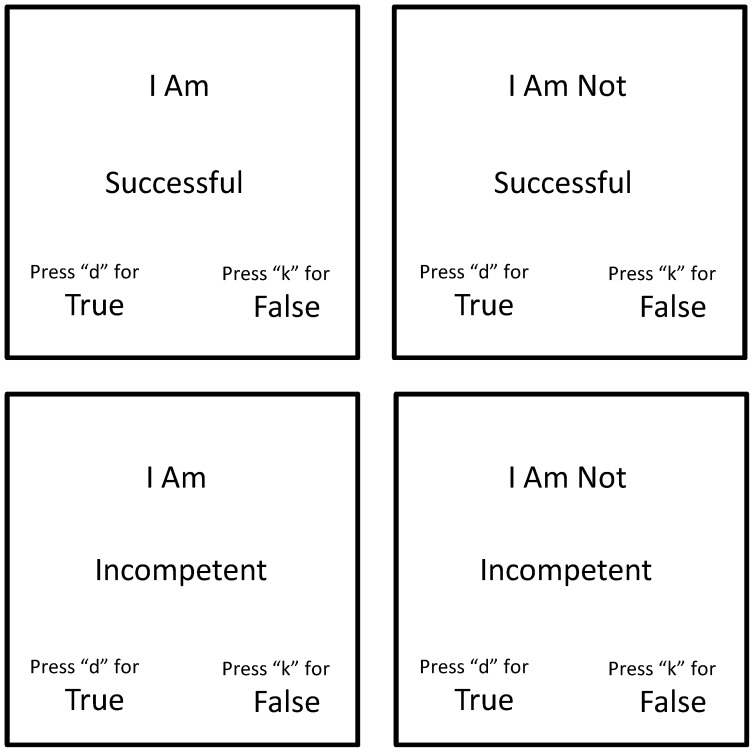
Examples of the four trial-types used in the actual self-esteem IRAP.On each trial, a label stimulus (e.g., ‘I am’ or ‘I am not’), a target stimulus (e.g., ‘Successful’ or ‘Incompetent’) and two relational response options (True and False) were shown on the screen. Note: the ideal and actual self IRAPs were identical in all regards except for their respective label stimuli (‘I want to be’ and ‘I don’t want to be’ versus ‘I am’ and ‘I am not’ respectively).